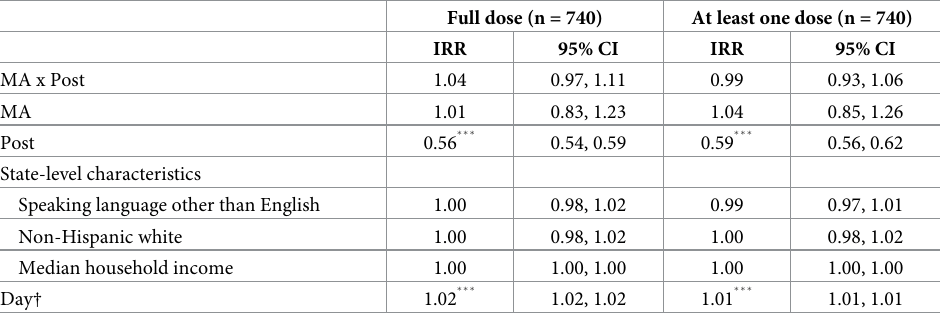
Table 3. Results of state-day level difference-in-differences regression estimates of Massachusetts COVID-19 vac- cine lottery on the number of vaccinations among adults 18 years or